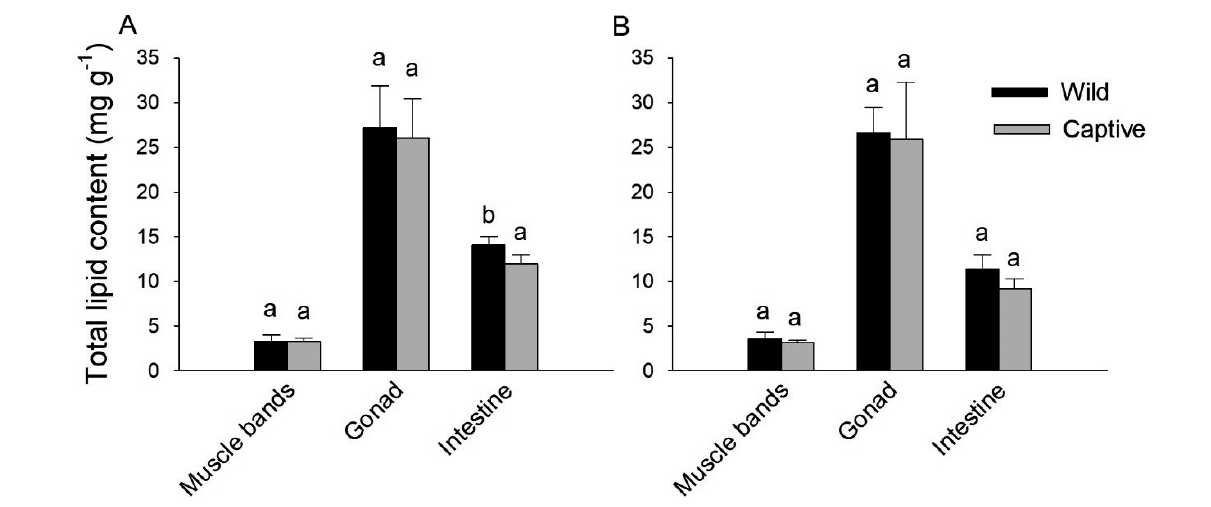
Fig. 4. Total lipids in muscle bands, gonad and intestine of (A) male and (B) female individuals of wild and captive (45 mo un- der IMTA conditions) Cucumaria frondosa . Data are shown as means ± SD (n = 4). Comparisons were made between wild and captive individuals ( t -test), and means with different letters are significantly different (p <